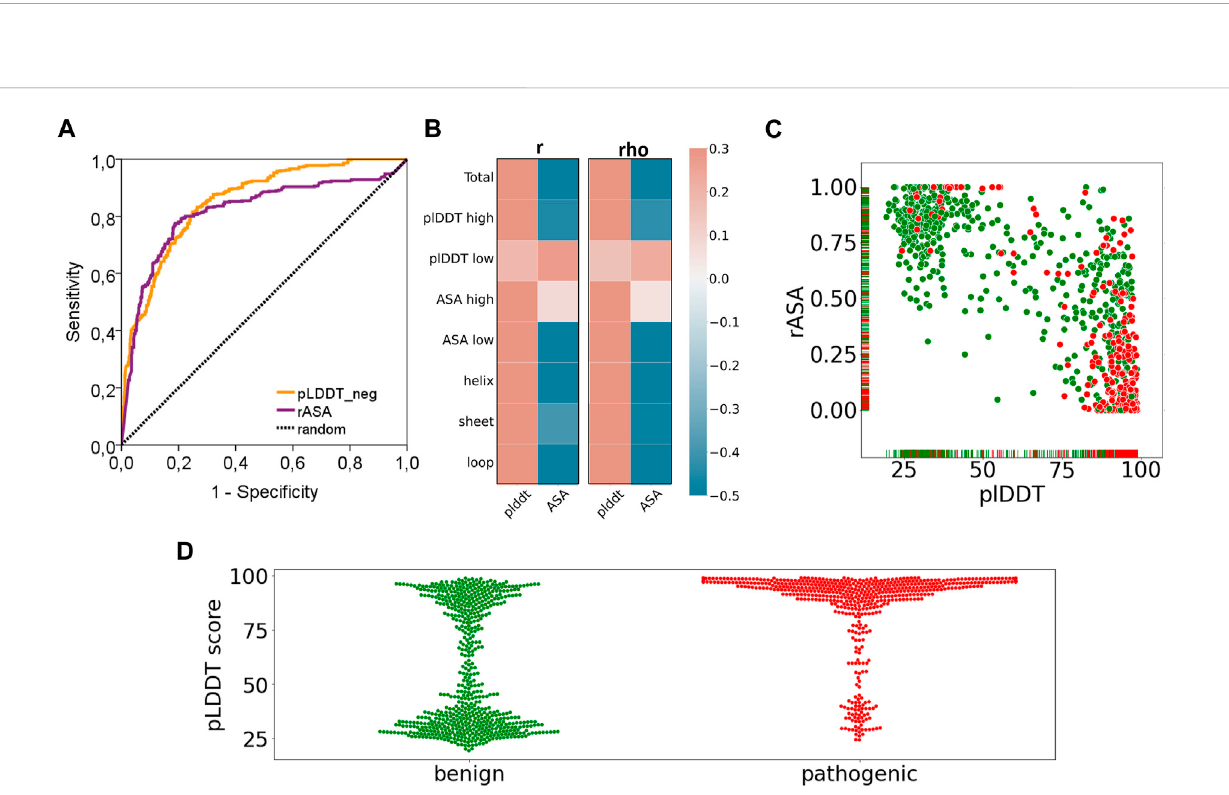
Performance of pathogenicity prediction of two characteristics of AF2 structures. (A) ROC curve and (B) correlation analyses of pLDDT and rASA values of the variants in the AF2 structures and (C) pLDDT vs rASA scatter plot and (D) pLDDT distributions (benign: green, pathogenic: